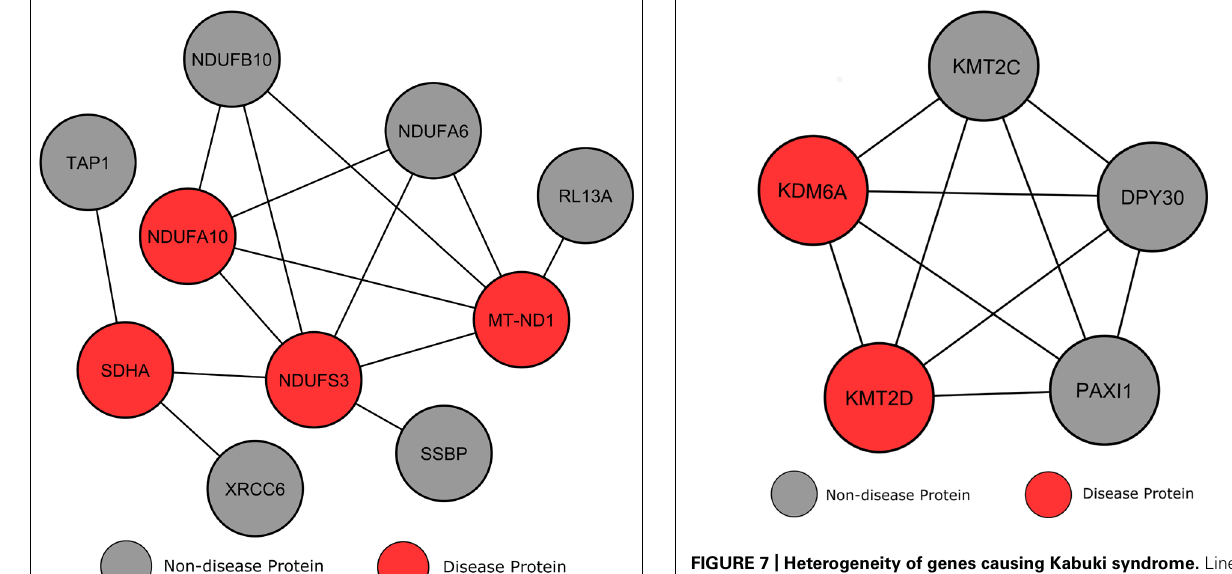
FIGURE 7 | Heterogeneity of genes causing Kabuki syndrome. Lines signify interactions between two proteins, represented by circular nodes. rearrangements and has been labeled as“the gatekeeper of thymo- cyte development” (Callen et al., 2012; Papatriantafyllou, 2013). Callen et al. (2012) have shown that PAXI1 has specific roles